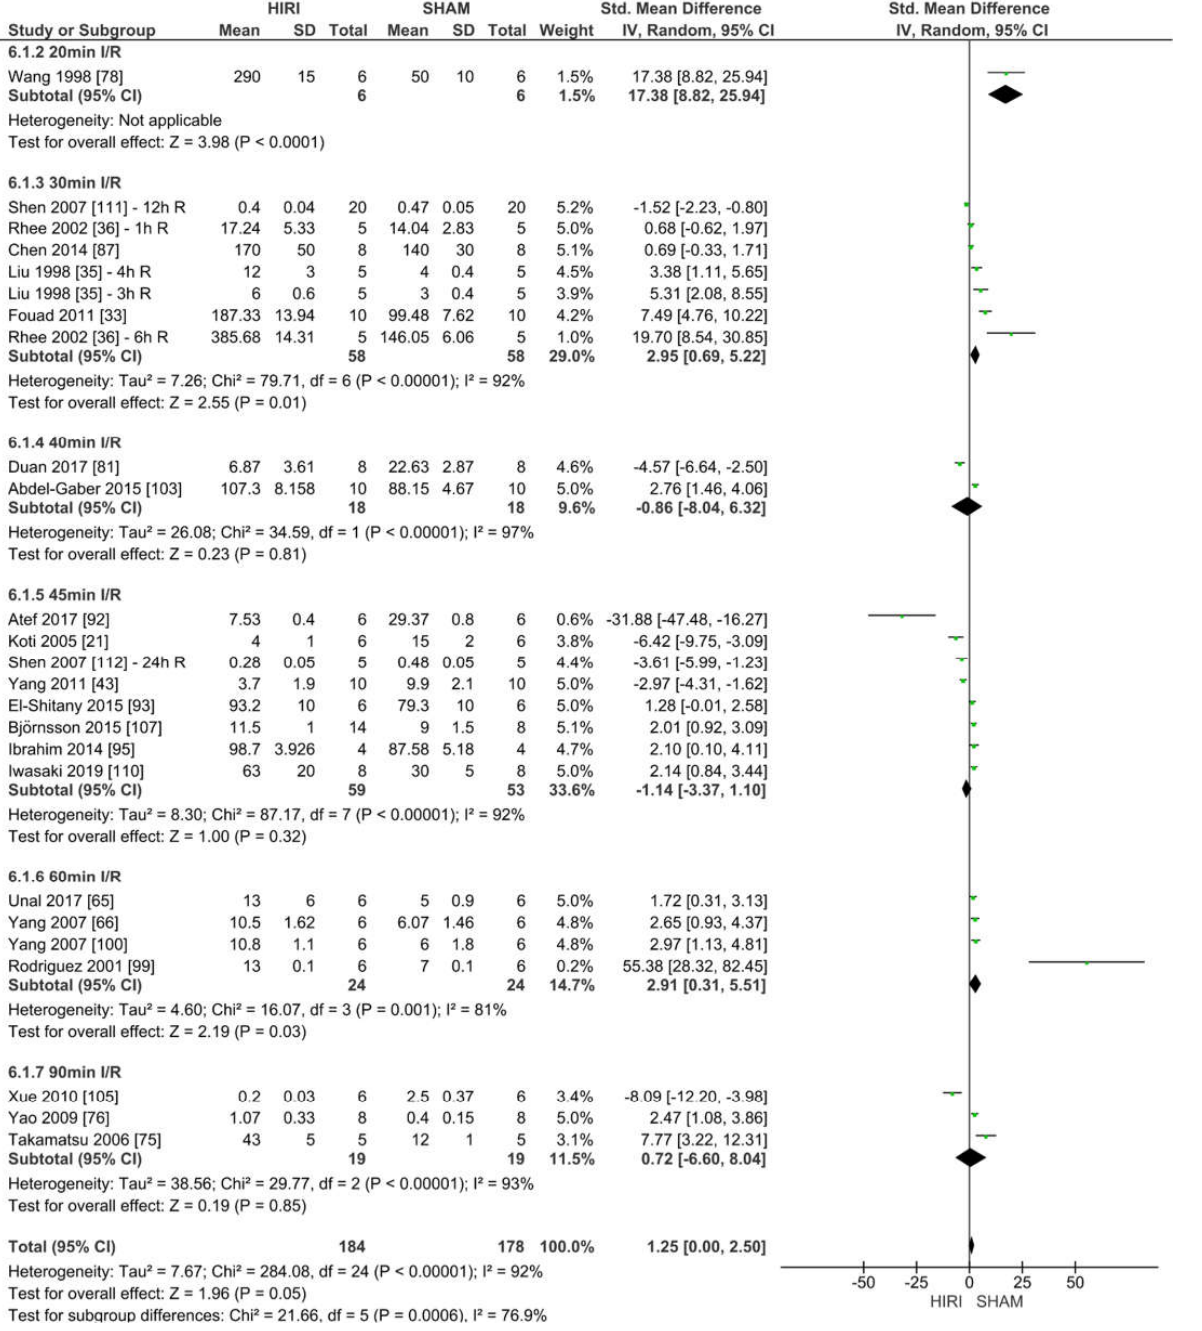
Figure 12. Forest plot of NO detection in SHAM groups versus HIRI grouped by different warm ischaemia durations.